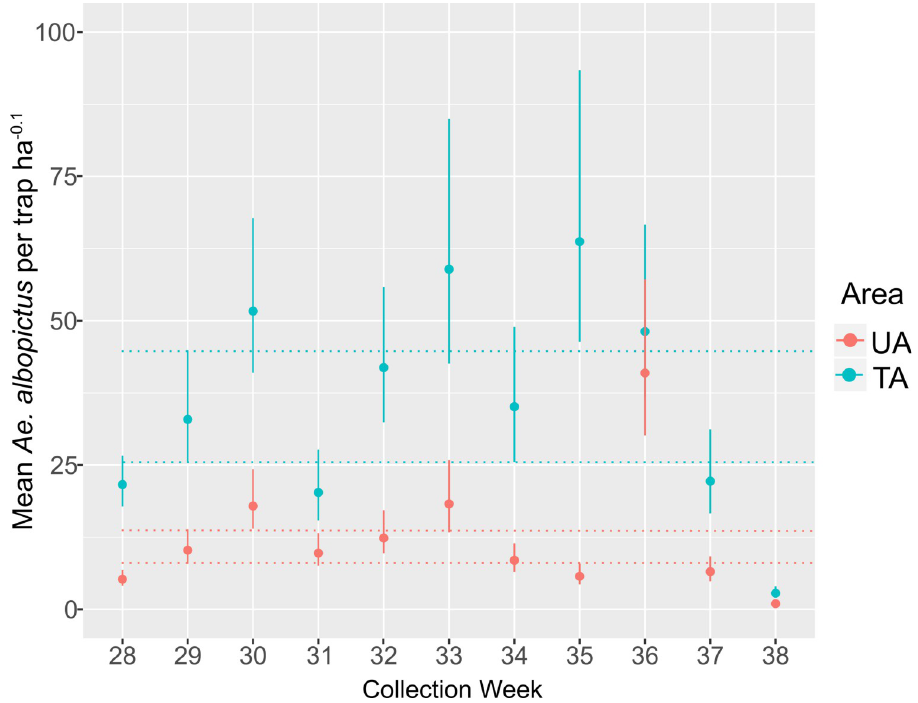
Fig 5. Relative abundance of Ae . albopictus females per week in the untreated and treated area. The center dot denotes the most probable value of the estimate. Error bars denote 95% credibility intervals (see the “Statistical Methods for Abundance Estimation” section for description of the mean and credibility intervals). The red dotted line represents the credibility interval for the UA abundance in week 29. The blue dotted line represents the credibility interval for the TA abundance in week 29. If the credibility intervals do not overlap the means are considered statistically different with a probability of 95%.